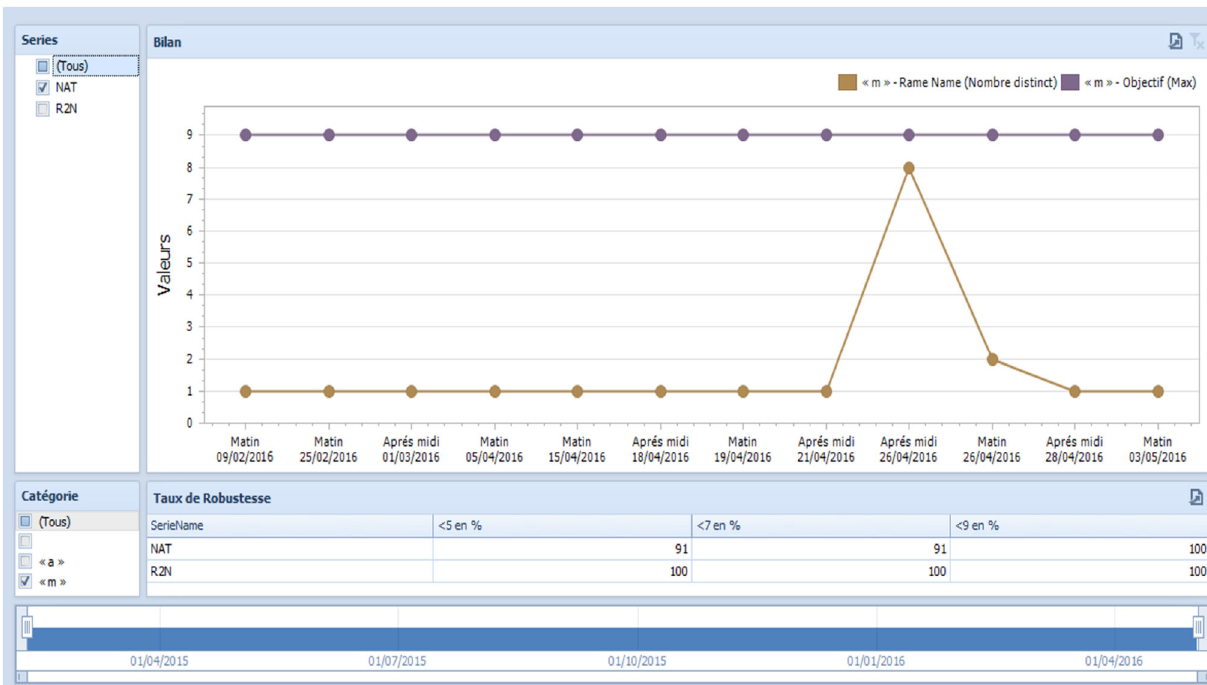
Fig. 16 Evolution of KPI#1 over several